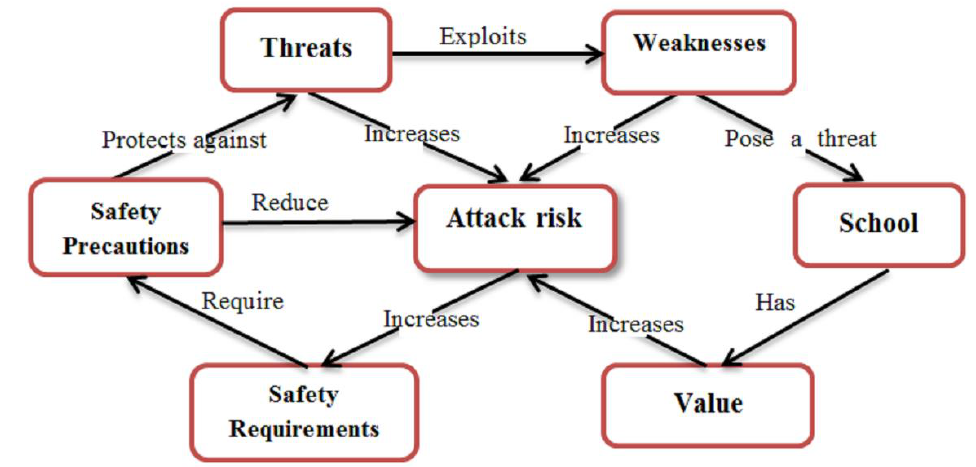
Figure 5. Interconnections between terroristic attacks risk management